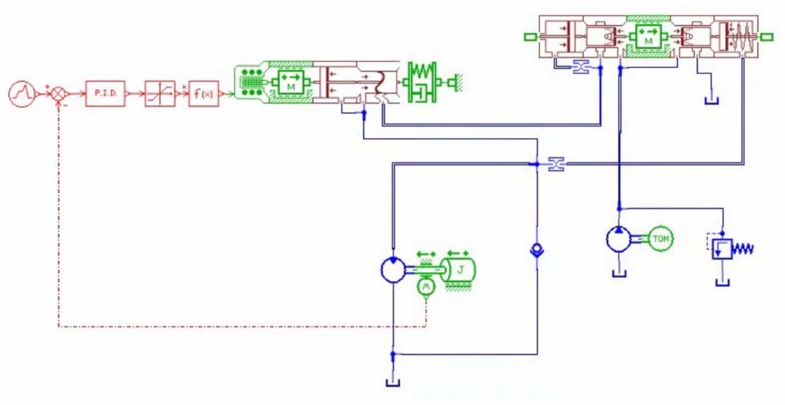
Figure 11. Closed-loop system of hydraulic motor controlled by proportional solenoid valve.